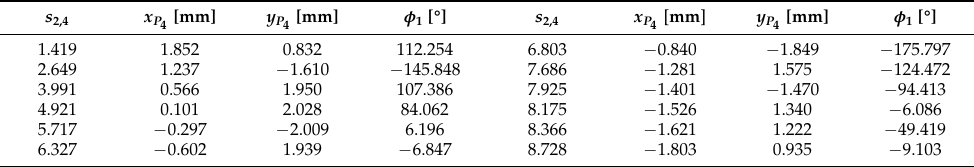
4,5,6 ) are found through bilateration and the pose π = ∈ { }